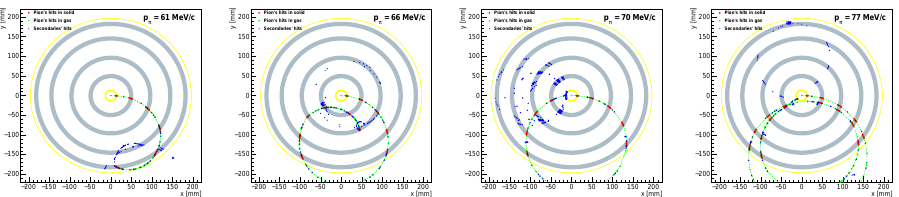
Figure 6. Cross-section of Inner Tracker based on cylindrical GEM detectors with hits, left by pion and secondary